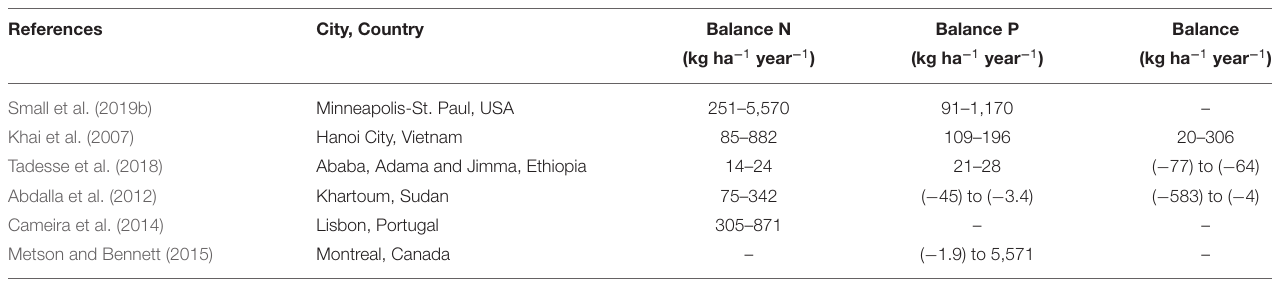
TABLE 5 | Ranges of garden-gate nutrient